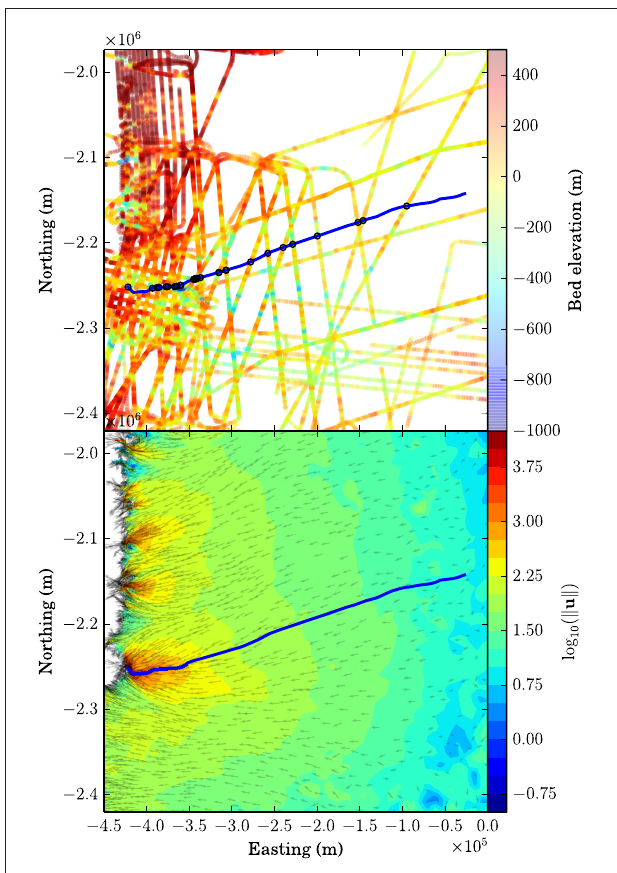
FIGURE 5 | Centerline of the flowband considered for Jakobshavn Isbræ(Blue). Also shown are log-scaled velocity vectors from Rignot and Mouginot (2012) , and bedrock elevations along Operation IceBridge flightlines derived from MCoRDS ice penetrating radar (Allen et al., 2015).